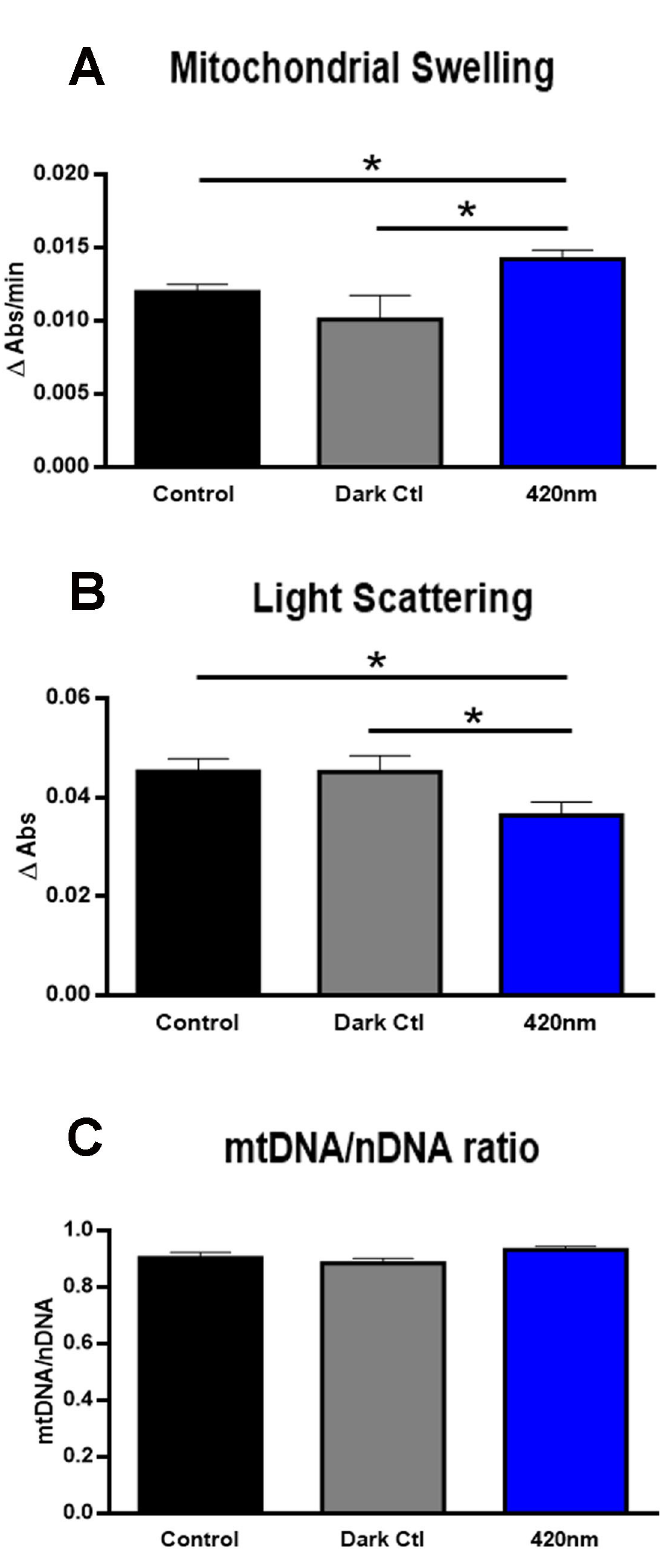
Fig 3. Mitochondrial membrane permeability and DNA content. Mitochondrial membrane permeability was determined by hypotonically induced mitochondrial swelling and the absorption changes were